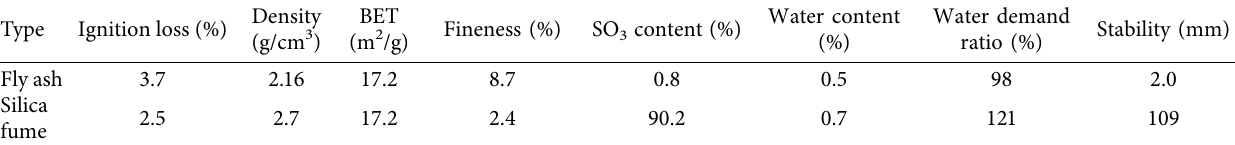
Table 3: Values of basic parameters for fly ash and silica fume.